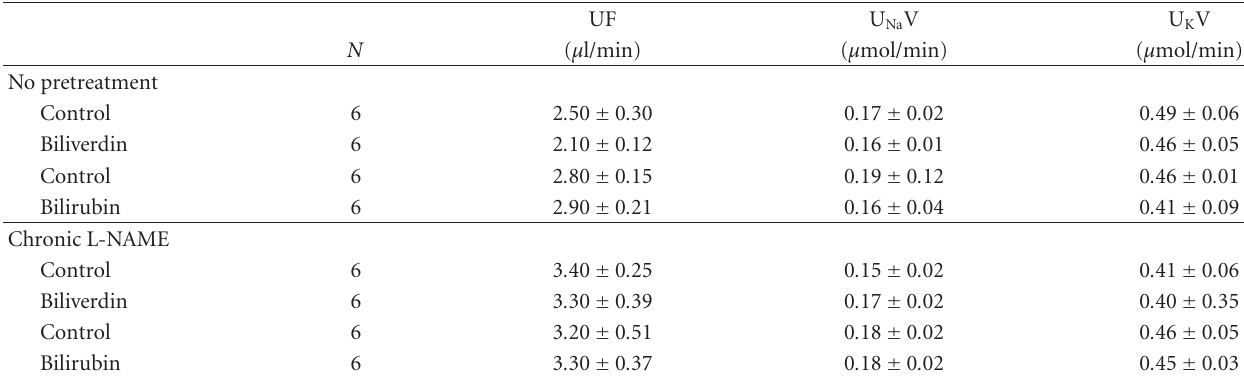
Table 3: E ff ects of biliverdin (20mg/Kg, IV) and bilirubin (30mg/Kg, IV) administration on urine flow (UF), sodium excretion (U Na V) and urinary potassium (U K